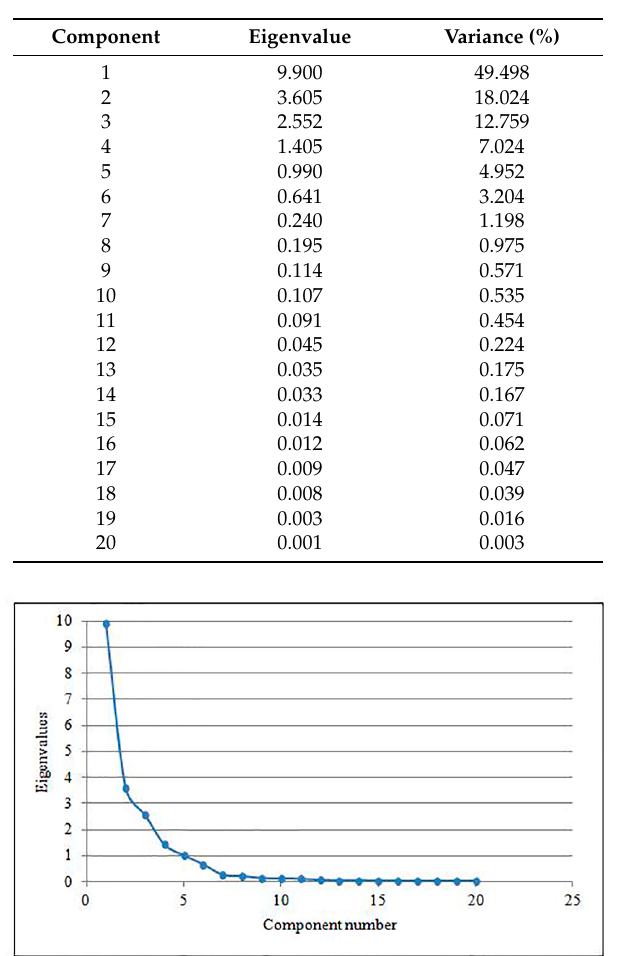
Figure 10. Scree graph of PCA on all the 20 bands.